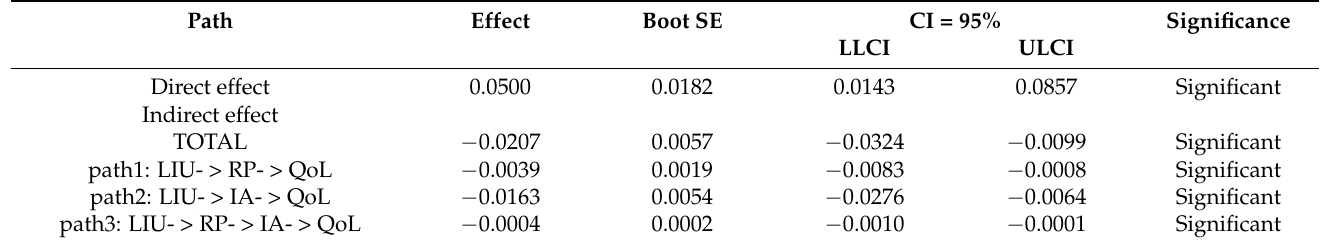
Table 5. Bootstrap analysis of significance test on mediating effect (for LIU).